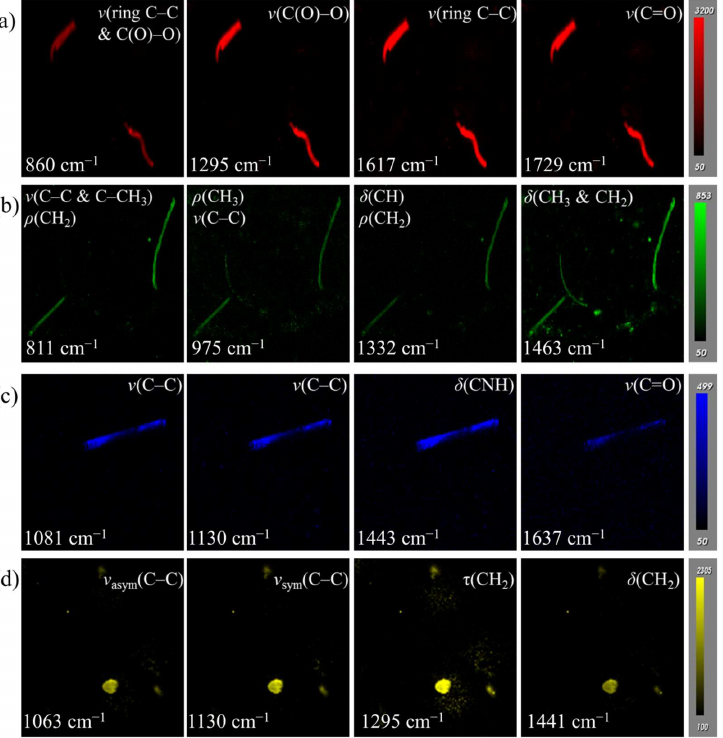
Figure 3. Raman imaging of ( a ) PET, ( b ) PP, ( c ) NY6, and ( d ) PE based on characteristic peaks. δ , v , v sym , v asym , ρ , τ, and ω represent the vibration of bending, stretching, symmetric stretching, anti-symmetric stretching, rocking, twisting, and wagging, respectively.